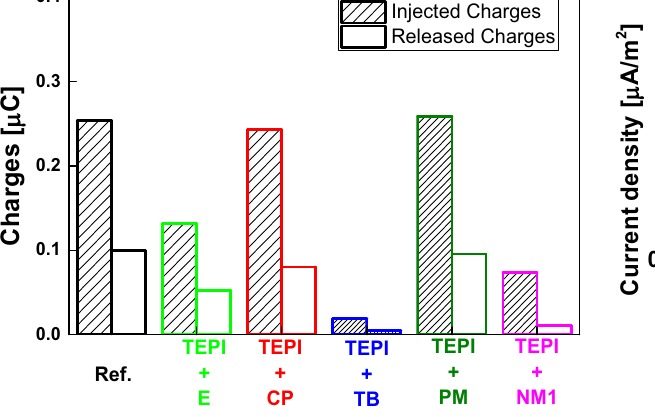
Figure 15: Calculated amount of injected and released charges.